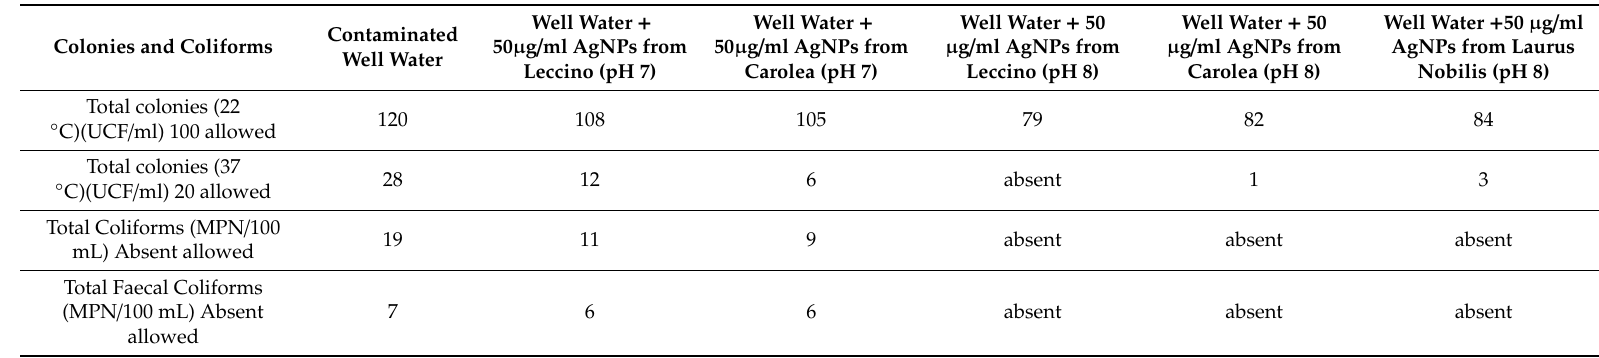
Table 3. Total colonies at 22 ◦ C and 37 ◦ C as UCF / ml and total coliforms and faecal coliforms as MPN / 100ml after exposure to 50 µ g / mL of green AgNPs. Colonies and